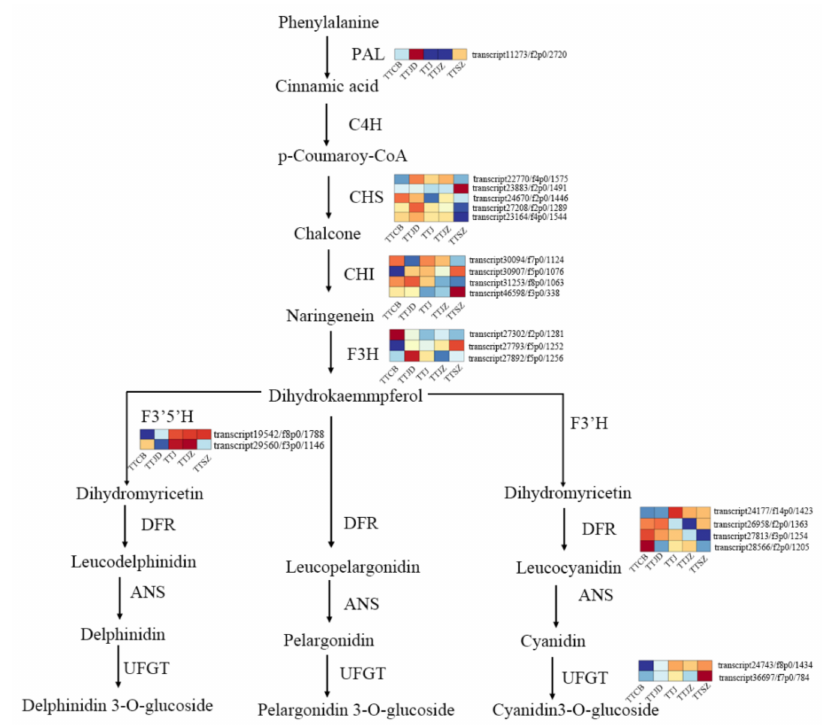
Figure 8. Expression of genes in the anthocyanin biosynthesis pathway. The expression of related genes in the RNA-seq data (FPKM) is represented by the rectangle. The high/low expression levels are represented by red/blue,